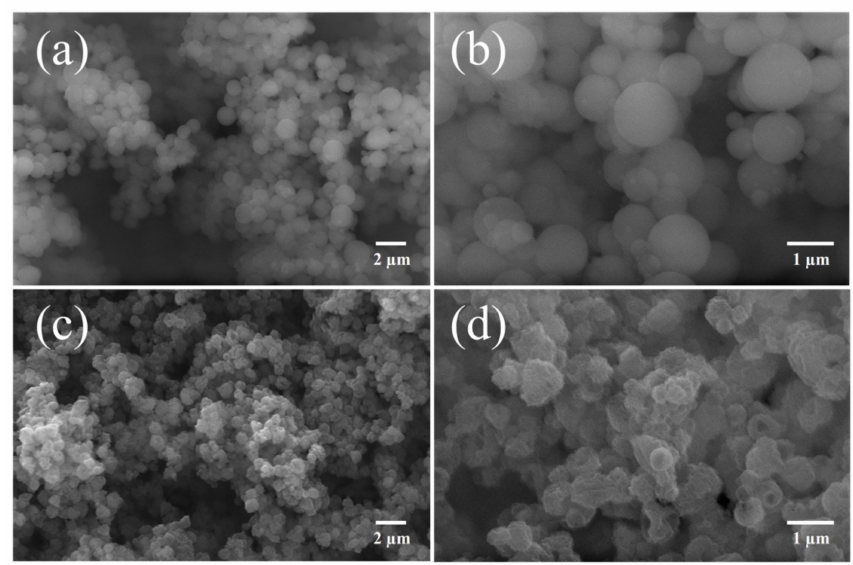
Figure 3. Scanning electron microscopy (SEM) images of ( a , b ) spherical PVP/Al 2 O 3 /Fe 2 O 3 particles and ( c , d ) hollow Fe 3 O 4 nanospheres.